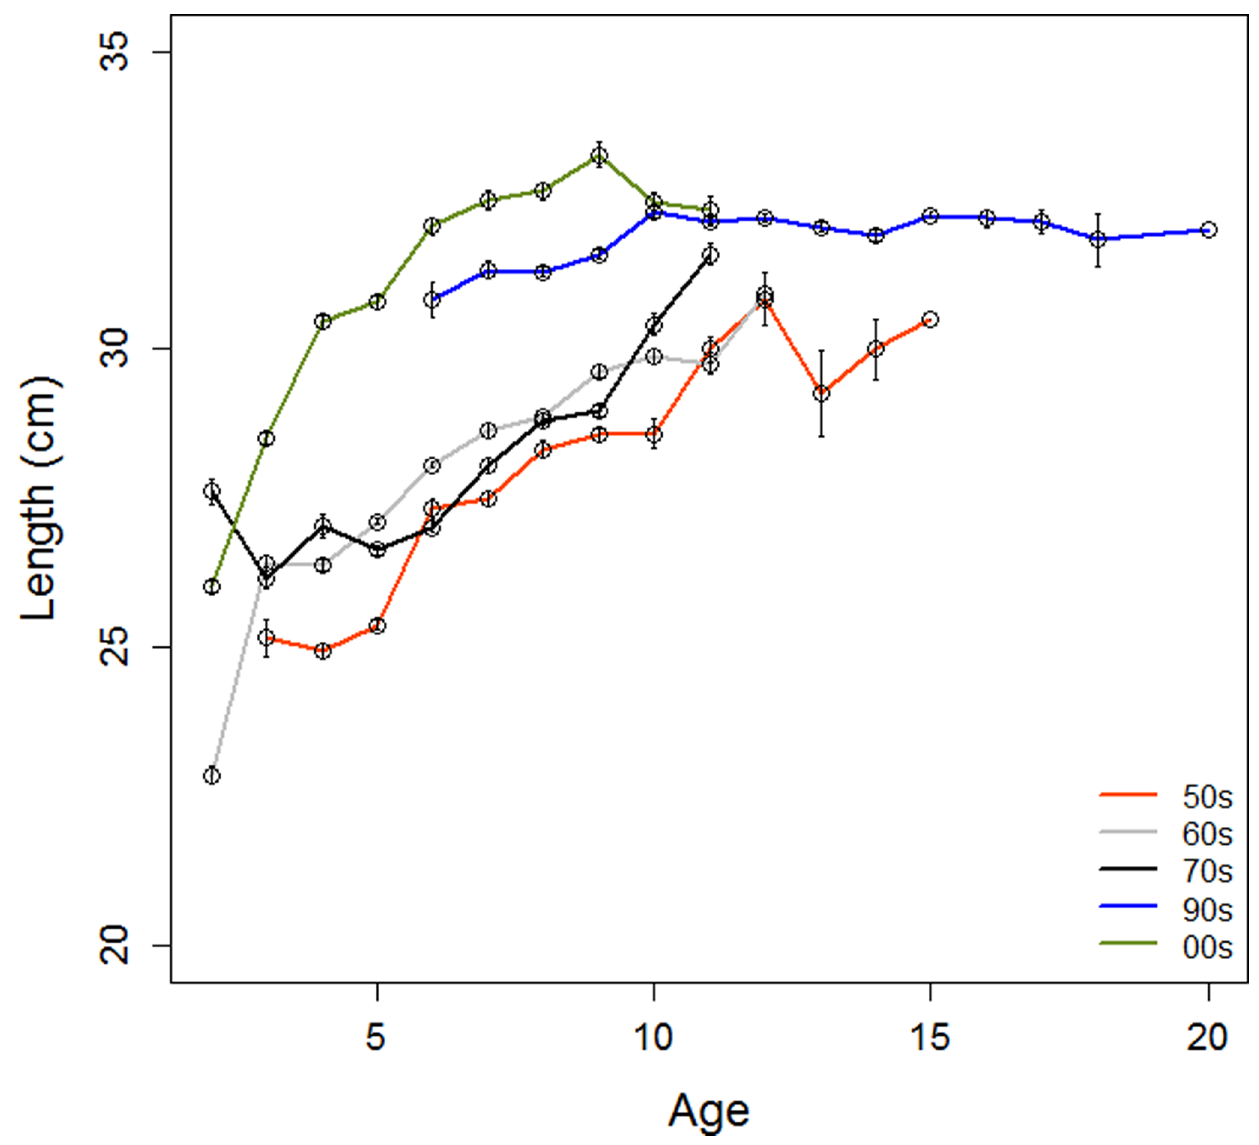
Figure 4. Average length-at-age. Mean 6 SE of YCs of the decades 1950s to 2000s.